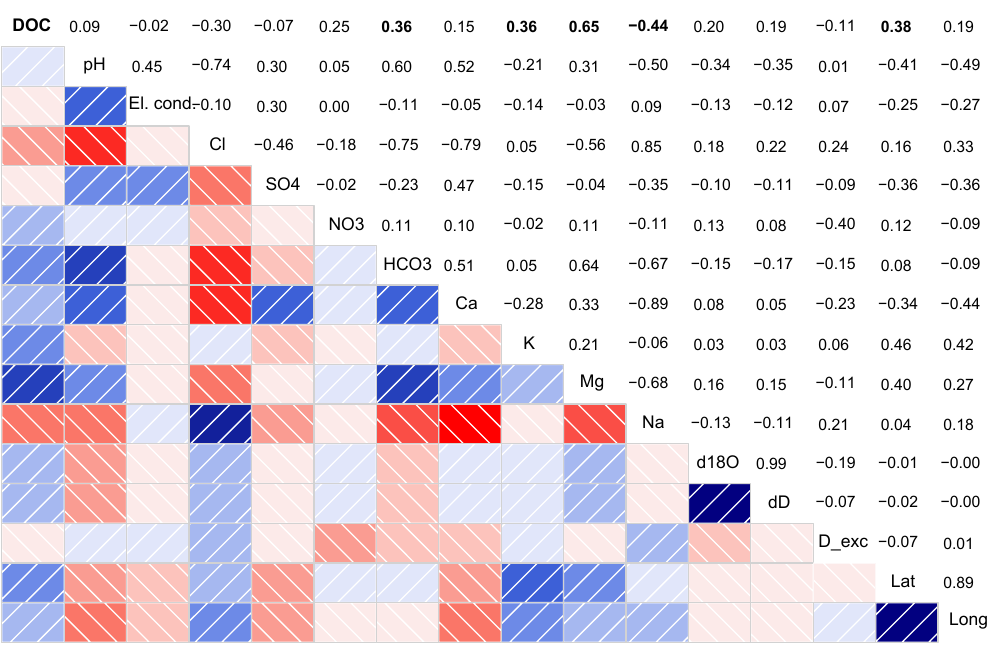
Figure 4. Correlation matrix. Correlations mentioned in the text are printed in bold. Strong positive correlations of paired variables are indi- cated by dark bluish colors, while strong anti-correlations are depicted in red. Hatching from the upper right to the lower left depicts positive correlations, whereas negative correlations are reversely hatched for better perceptibility in a black-and-white print. (For interpretation of the references to color in this figure legend, the reader is referred to the web version of this